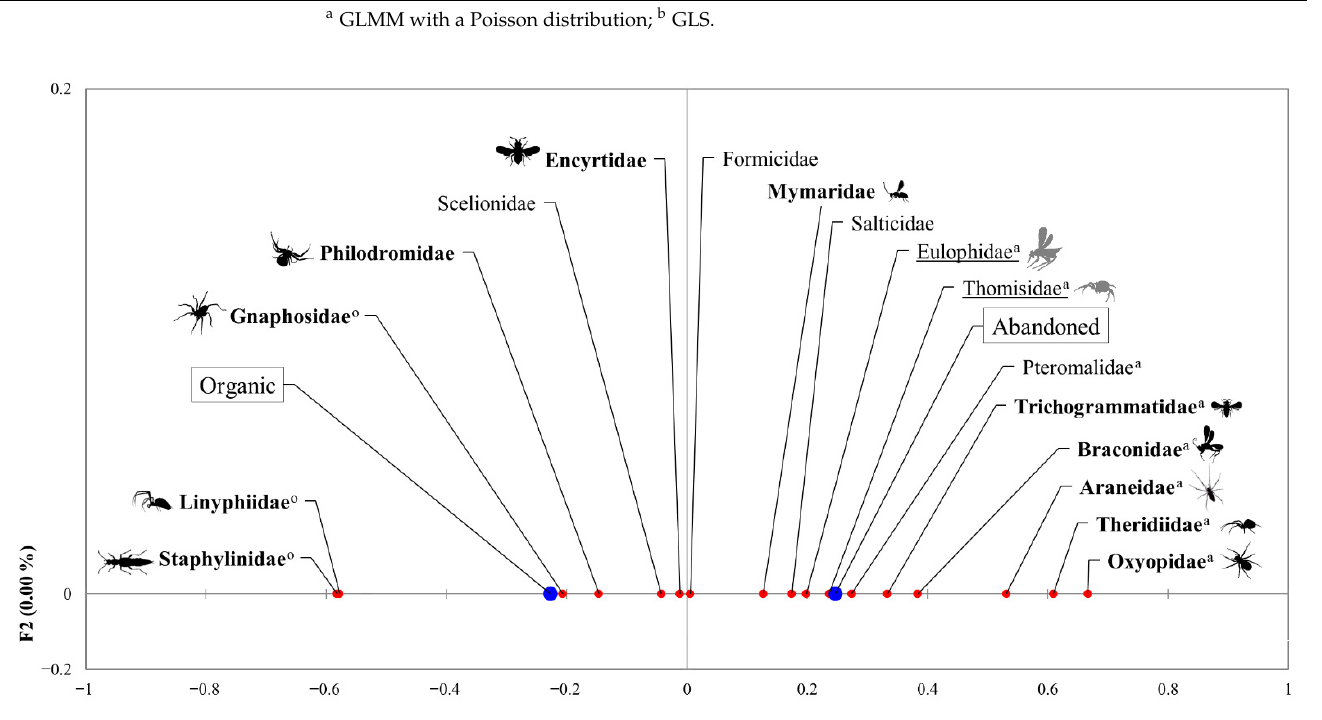
Figure 4. Factorial correspondence analysis was performed on the abundance of the most relevant families of natural enemies on each type of system (organic and abandoned). Families in bold with black drawings were those significantly affected by the variable system , whereas underlined families with grey drawings were marginally affected by this variable, according to the results obtained from the linear models fitted on the abundances of the most dominant families. Red dot: principal coordinate value for each family in the first axis of the FCA; blue dot: principal coordinate value for each farming system in the first axis of the FCA. o Significant association with the organic groves in the correspondence analysis; a significant association with the abandoned groves in the correspondence analysis.